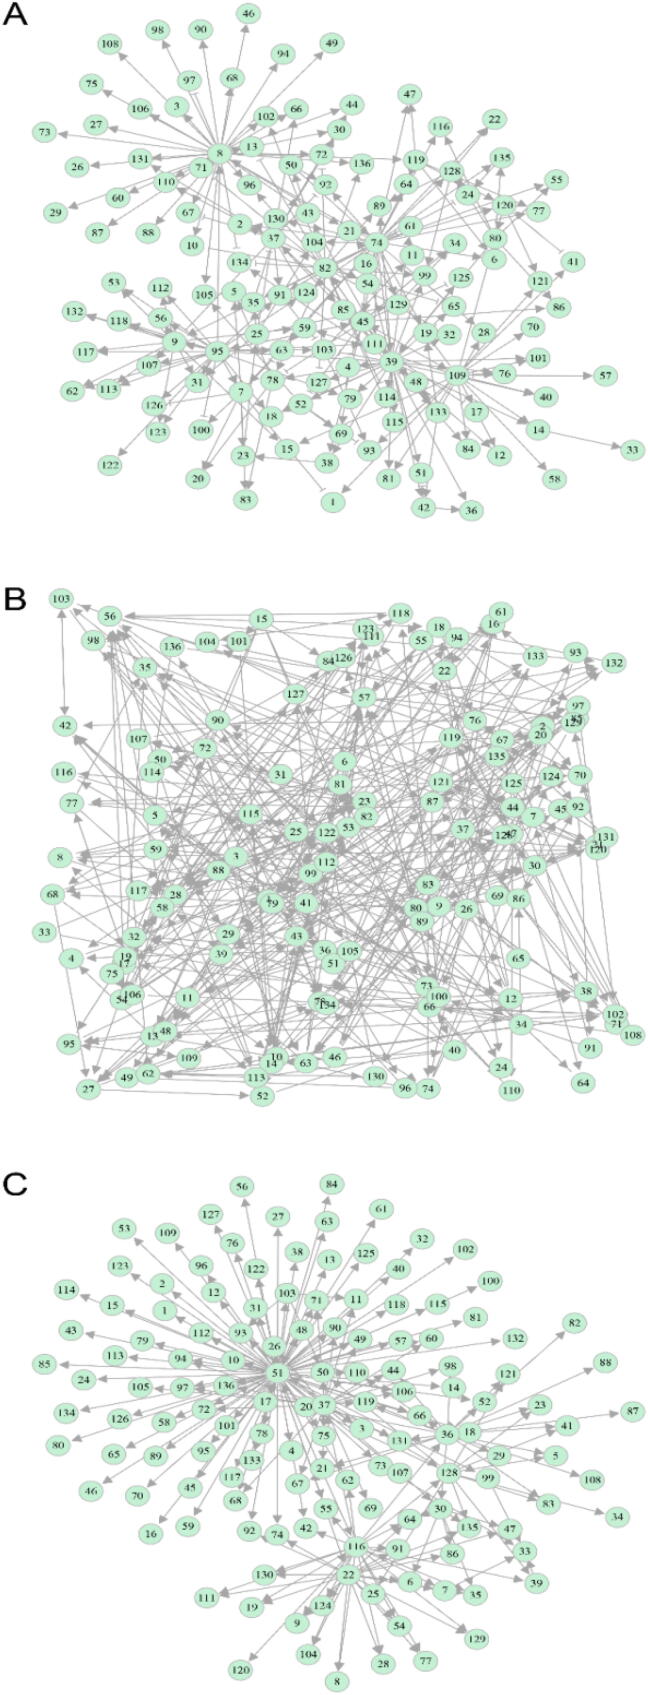
Gene regulatory networks among 136 genes from module 4 reconstructed by SEGM (A), G1DBN (B), and SA-ODE (C).